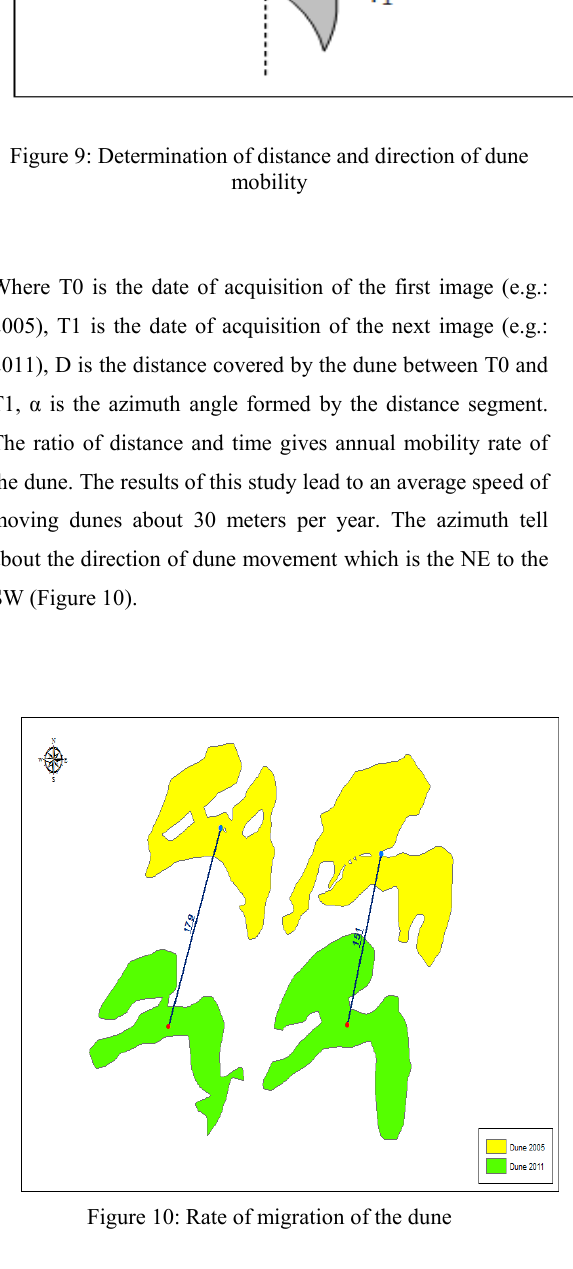
In addition, the azimuth angle relative to this segment provides information on the direction. The obtained results show that the dune movements are characterized by a direction from the NE to the SW. These results are